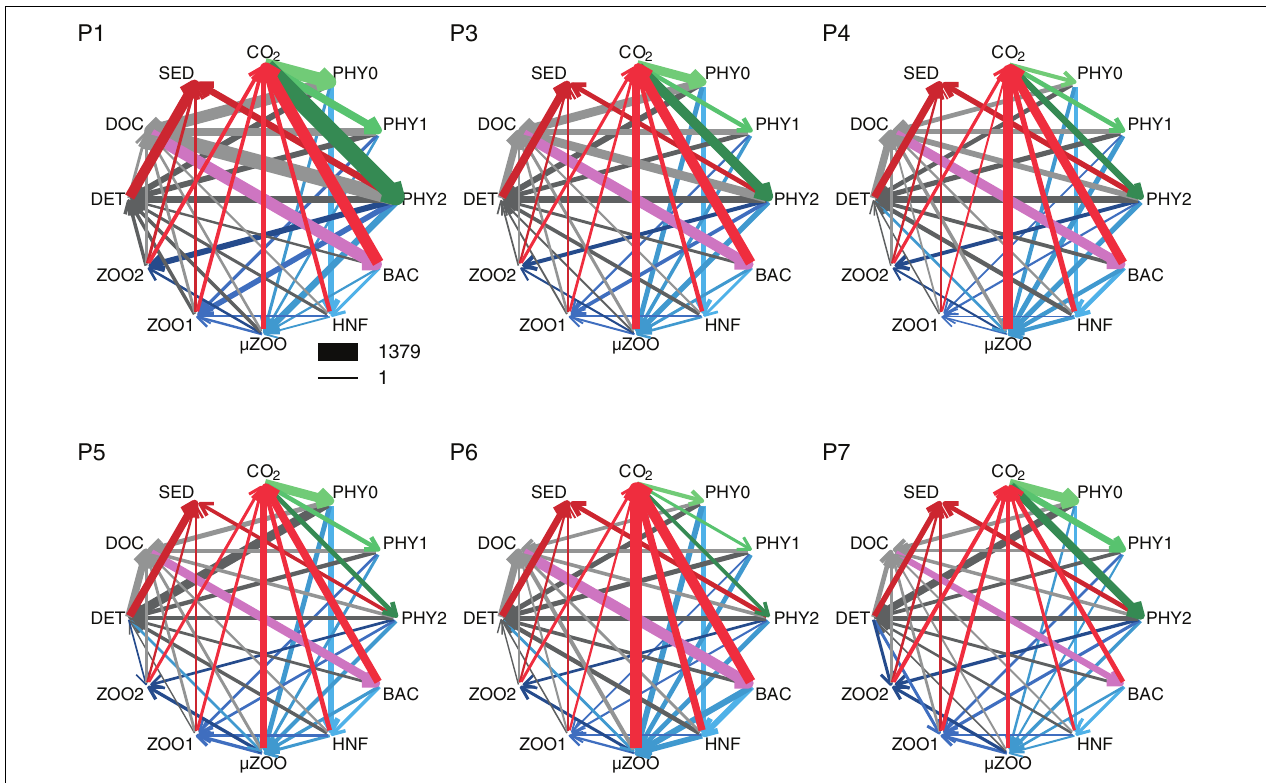
FIGURE 7 | The carbon flows in stations P1–P7, as reconstructed from the field measurements by the inverse method (numerical values in Supplementary Table S3 ). The thickness of arrows is proportional to the square root of the respective flows, and have the same scale in all plots, as indicated by the legend (mg C m − 2 d − 1 ). Note the very low primary production in P6. Phototrophic flows are in green, carbon losses to SED and CO 2 are in red, grazing flows are blue, bacterial assimilation violet, and flows to non-living organic compartments, DOC and DET, are in gray.